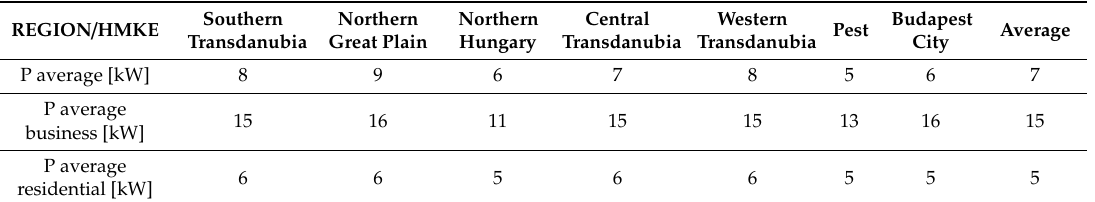
Table 3. Average household-size small photovoltaic power plants’ power in the seven examined regions of Hungary.